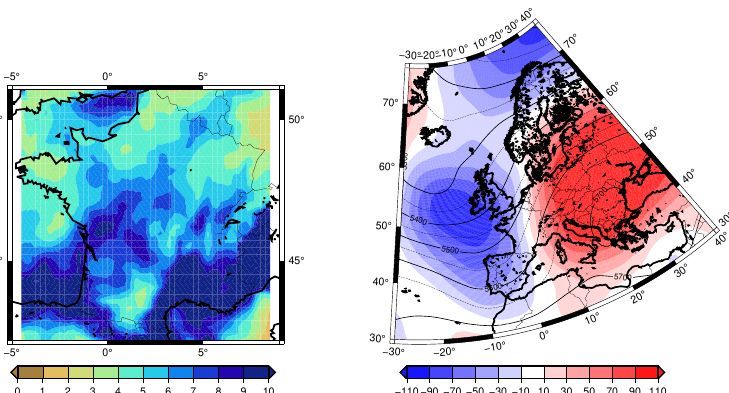
Figure 7. Left panel : mean precipitation rate (in mm/day) over France between 13 October 2019 and 25 October 2019. Right panel : mean anomalies of Z500 (in m) over the East North Atlantic region (colours). Contour lines indicate the mean Z500 (in